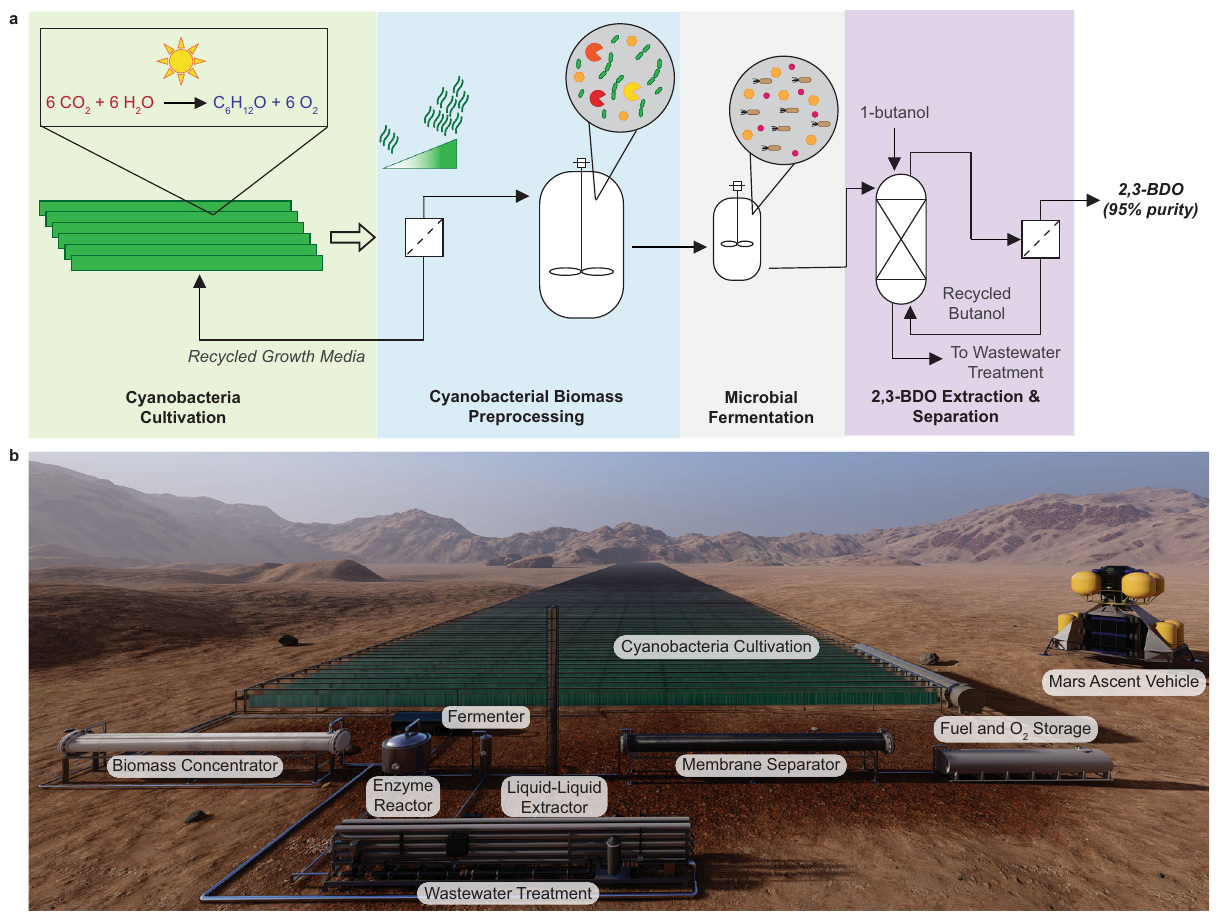
Fig. 3 Continuous bio-ISRU production of 2,3-BDO on Mars. a The bio-ISRU production of 2,3-BDO is composed of four modules: (1) Cyanobacterial cultivation in photobioreactors or bio fi lm growth (shaded green), (2) Cyanobacteria biomass preprocessing composed of biomass concentration via membrane fi ltration and enzymatic digestion in a stirred tank (shaded blue), (3) Microbial fermentation of the cyanobacterial glucose to produce 2,3-BDO (shaded gray), (4) 2,3-BDO extraction and separation via sequential liquid – liquid extraction and membrane separation to achieve 95% purity (shaded purple). Chemical formula: Red Martian resources. Blue chemicals made on Mars. b Rendering of what the bio-ISRU for 2,3-BDO process might look like on Mars, with a Mars Ascent Vehicle included for scale. The cyanobacterial cultivation module makes up the majority of the material and land